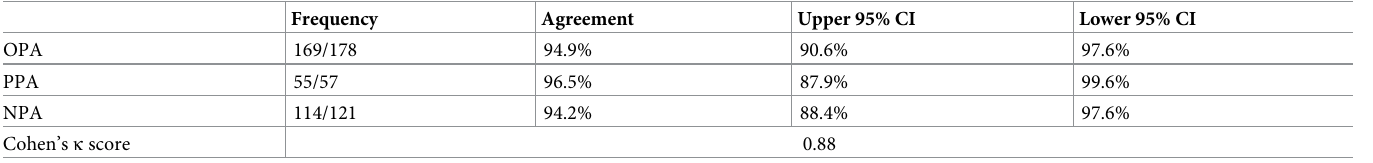
Table 2. Diagnostic performance of QIAreach QFT assay using QFT-plus as a reference